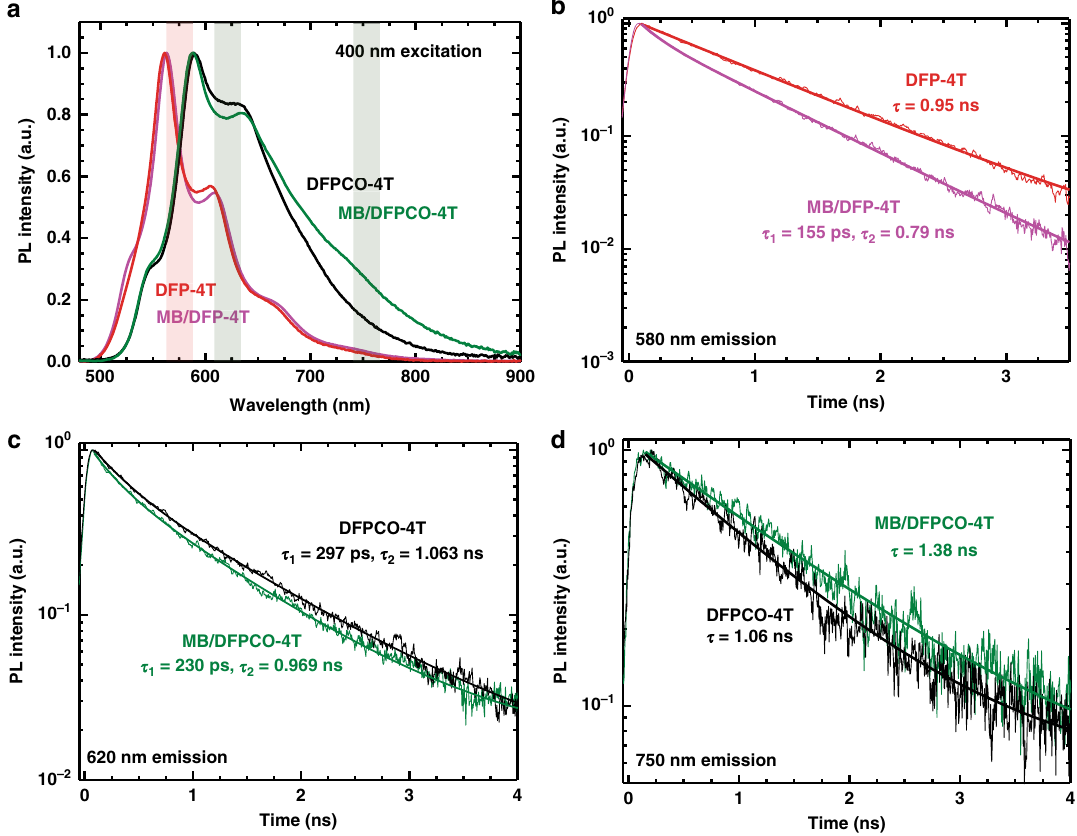
Fig. 4 Photoluminescence spectroscopy measurements. a Steady-state and ( b – d ) transient photoluminescence of fi lms upon 400 nm excitation (The shaded areas in a indicate the spectral regions wherein PL dynamics were investigated in b – d ). The steady state spectra of the DFP - 4T system are virtually identical in both cases ( a ), but a quicker decay of the main emission in the transients of MB/ DFP - 4T points to a charge transfer towards MB ( b ). The DFPCO - 4T system shows a marked increase in the PL around 750 nm upon MB deposition. The main emission occurs slightly faster c for MB/ DFPCO - 4T , but signi fi cantly slower in the tail region d .